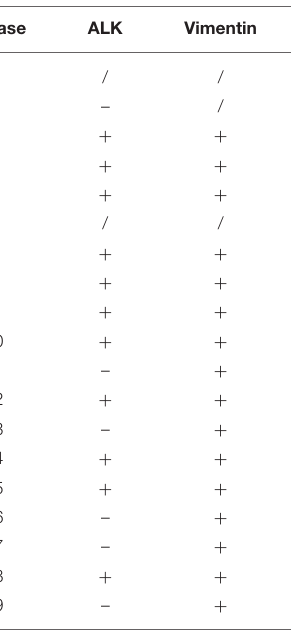
TABLE 2 | Immunohistochemistry